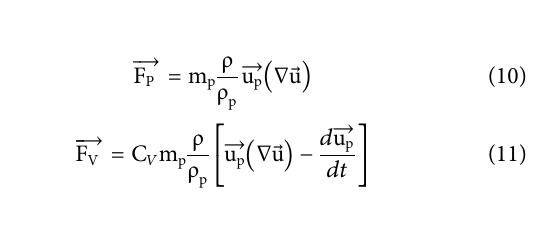
FIGURE 4 | Inlet fl ow curve displayed for 1 representative cardiac cycle of 0.8 s. For the outlet boundary condition methodology, both healthy and tumoral fl ow contributions (which is 0 for outlets perfusing 0% of the tumor mass) are calculated for each outlet (shown here for outlets 46, 47, 48 in segment